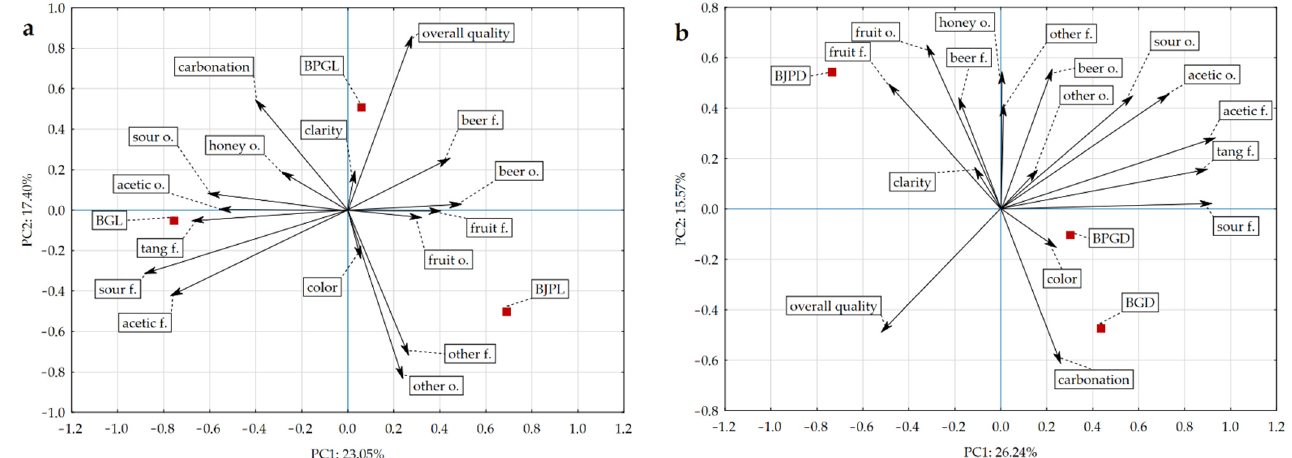
Figure 3. Principal component analysis (PCA) in the QDP sensory evaluation of beer beverages. Explanatory notes: projection of variables (sensory discriminants) and cases (tested samples) onto the plane of the principal components (PC1 and PC2). o.: odor; int.: intensity; f.: flavor; ( a )—light beer; ( b )—dark beer.